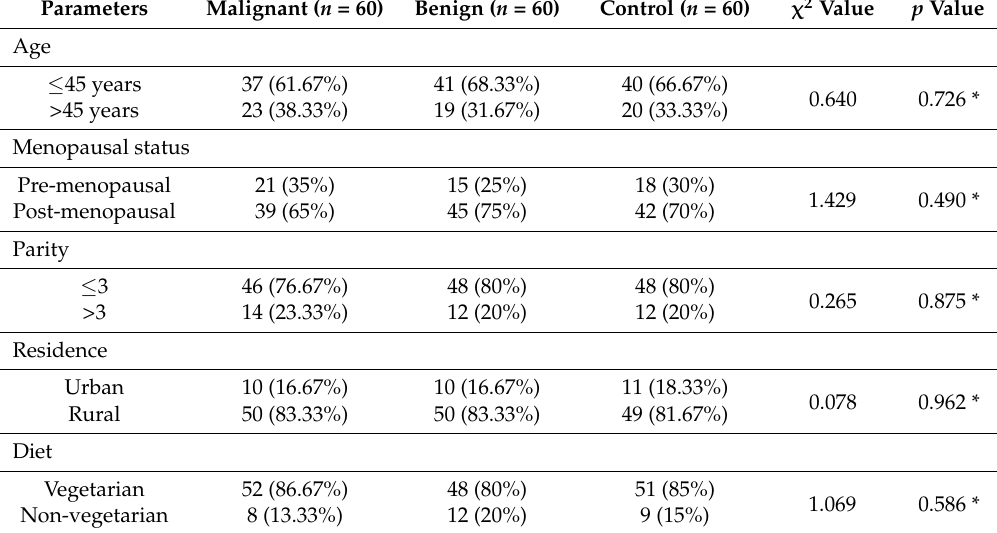
Table 2. Patient